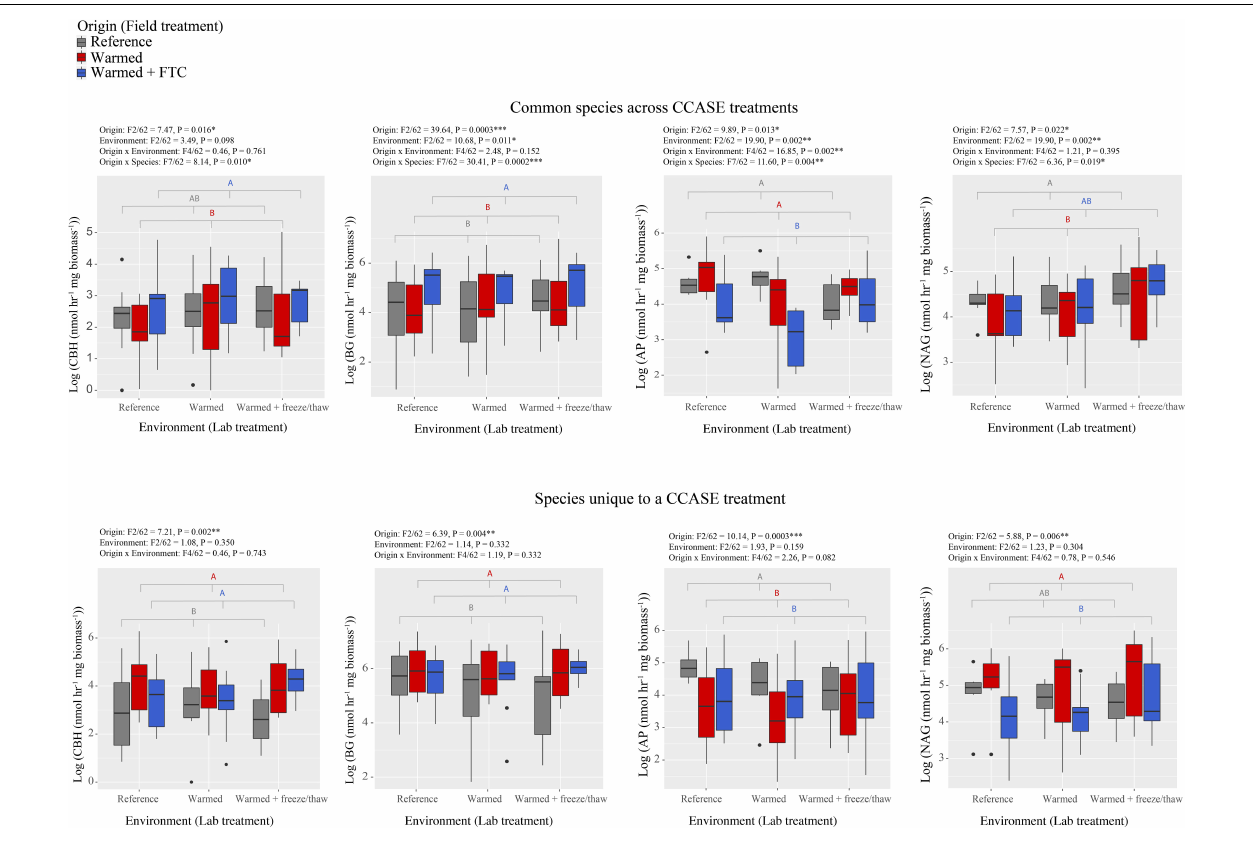
FIGURE 1 | Enzyme activities generated by fungi isolated from climate change across seasons experiment (CCASE) plots and incubated in the laboratory common garden experiment. Common species consisted of nine species, each isolated from two CCASE treatments: reference and warmed plots ( n = 4), reference and warmed + FTC plots ( n = 3), or warmed and warmed + FTC plots ( n = 2). Unique species consisted of 20 species, each of which were found only in one CCASE treatment. Enzymes showing significant activity differences among fungal isolates from different CCASE treatments include cellobiohydrolase (CBH), β -glucosidase (BG), acid phosphatase (AP), and N -acetyl glucosaminidase (NAG). Statistics were generated from factorial analysis of variance (ANOVA) with CCASE field treatment (origin) of isolates, laboratory treatment (environment), their interaction, and species as fixed independent variables and plot as a random